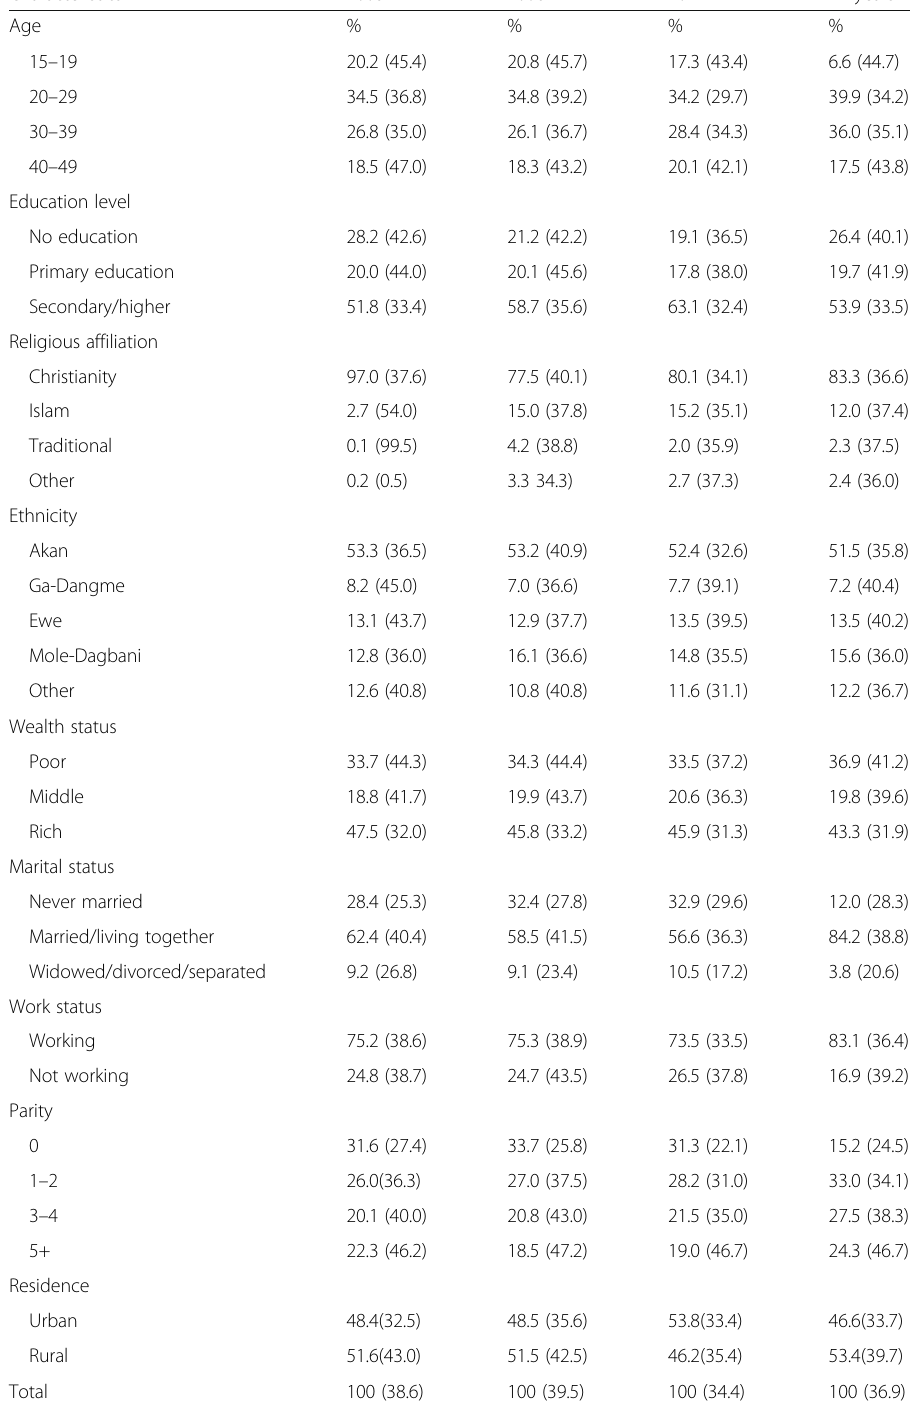
Table 1 Socio-demographic characteristics and prevalence of unmet need: 2003 – 2014